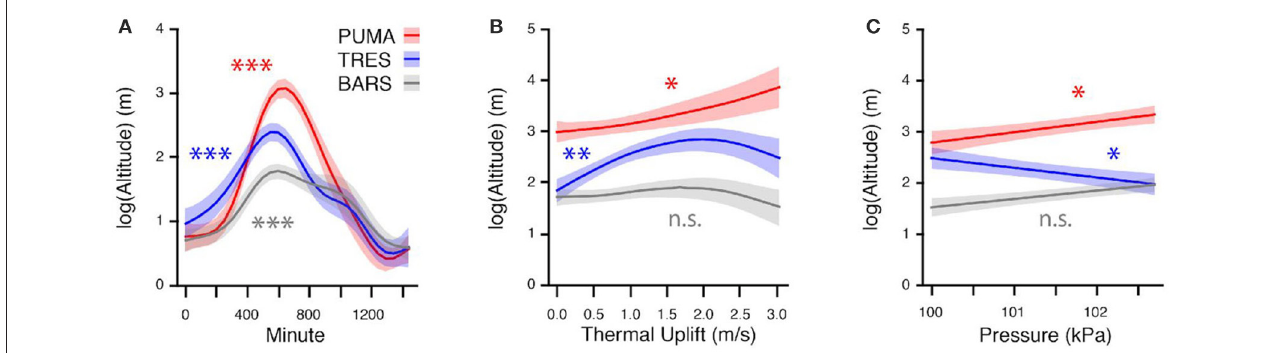
FIGURE 3 | Relationship between predictor variables and flight altitude for three study species. The shaded region represents the standard error for each smooth function estimate. In the first subfigure (A) , the relationship between time of day (Minute) and altitude is significant for all three species, with highest altitudes occurring near mid-day. In subfigure (B) , Altitude significantly increases with thermal uplift for Purple Martins (PUMA) and Tree Swallows (TRES), but not for Barn Swallows (BARS). In the final subfigure (C) , there is no clear relationship between atmospheric pressure and flight bout altitudes, with PUMA and TRES having significant but opposite effects. *** p < 0.001, ** p < 0.01, * p < 0.05, n.s., non-significant.